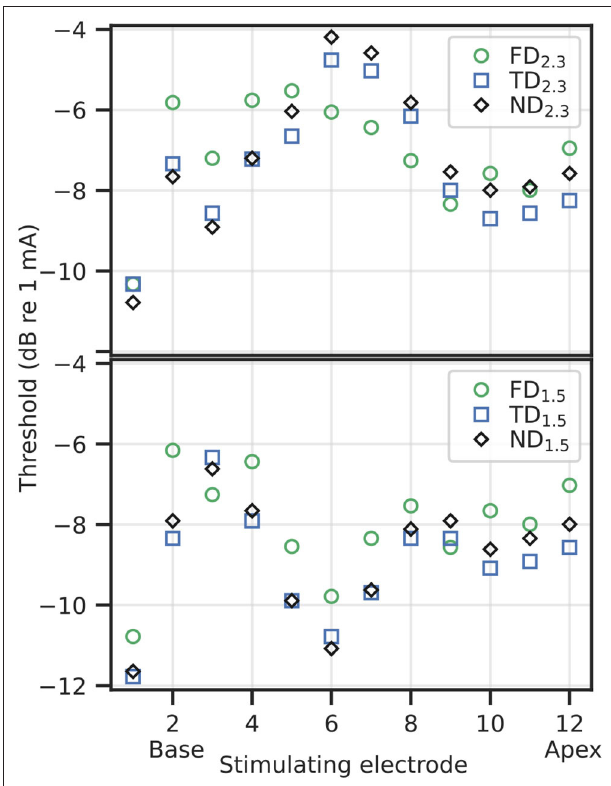
FIGURE 6 | Thresholds for individual stimulation electrodes and degenerative states, 2.3mm dendrite on top, 1.5mm dendrite on bottom.